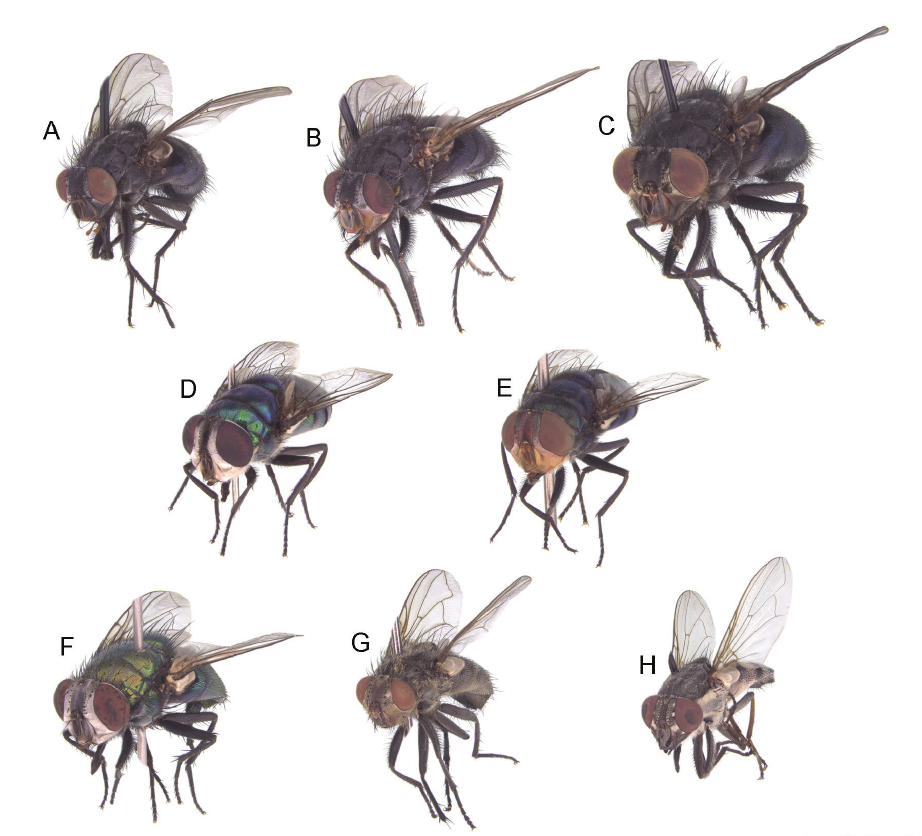
Figure 3. Habitus in antero-lateral view of Madeiran blowflies: A Calliphora loewi B Calliphora vicina C Calliphora vomitoria D Chrysomya albiceps E Chrysomya megacephala F Lucilia sericata G Pollenia rudis H Stomorhina lunata